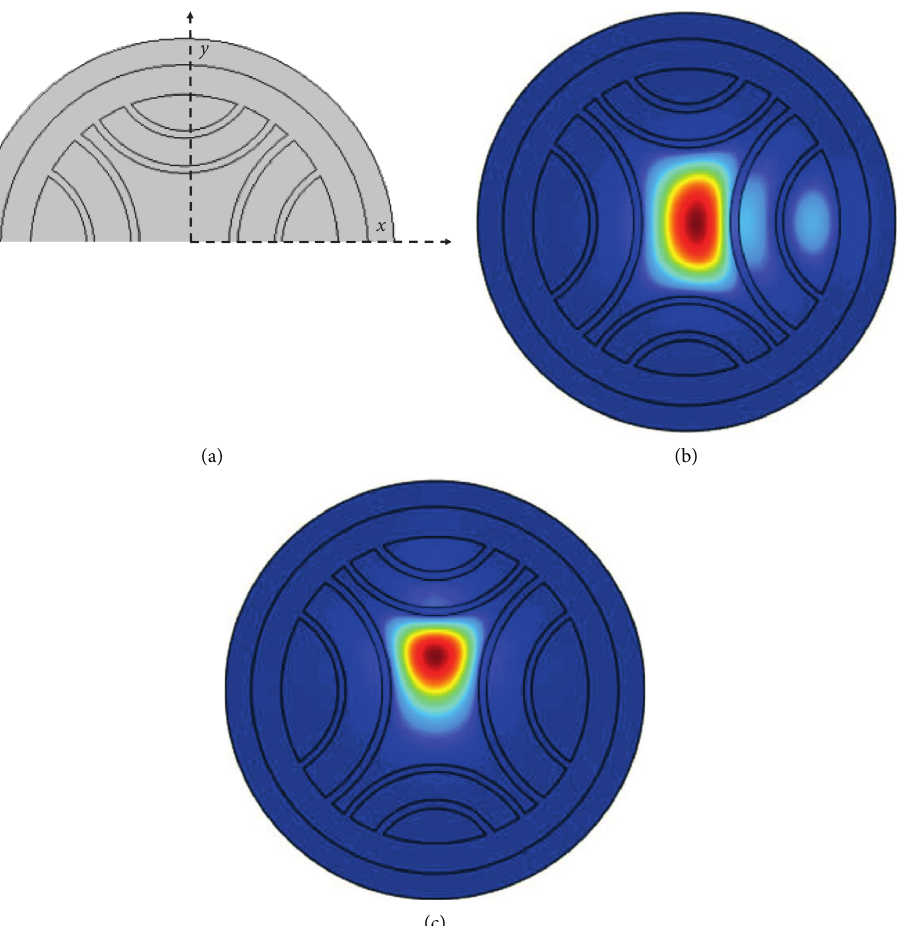
Figure 9: (a) Bending directions, fundamental mode in the wavelength of 1550nm at (b) x and (c) y bending direction.